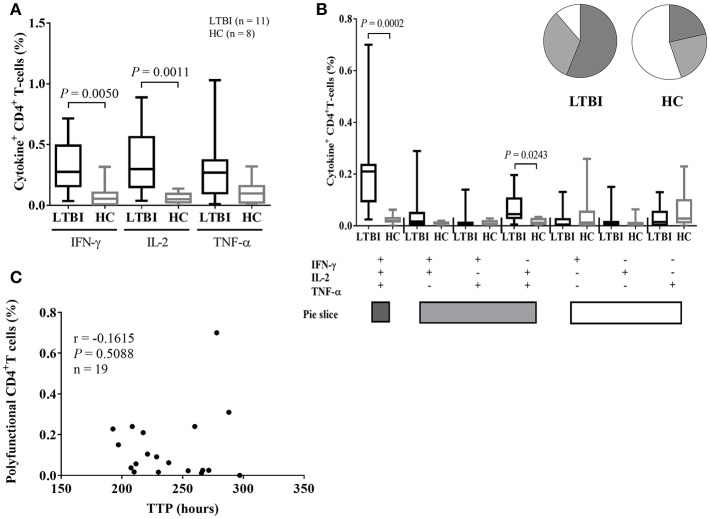
ICS data in LTBI and healthy control groups and correlation between mycobacterial growth inhibition and ICS responses. (A) Single cytokine expression data including IFN-γ, IL-2, and/ or TNF-α for individuals with LTBI (black bars, n = 11) and healthy controls (gray bars, n = 8). The PPD-specific CD4+ T-cell populations making IFN-γ and IL-2 are dominant in the LTBI group. (B) The polyfunctionality of CD4+ T-cell populations in individuals with LTBI (black bars) and HCs (gray bars). The PPD-specific polyfunctional T helper-1 cells are the dominant cell type in the LTBI group. Whole blood samples obtained from healthy adults were stimulated with PPD overnight and CD4+ T-cells assessed for cytokine secretion by intracellular staining. All ICS data is plotted as bars showing medians and interquartile ranges. Whiskers show the range of the data. The Mann-Whitney U-test was used to determine significance. (C) Scatter plots of TTP in hours vs. the percentage of polyfunctional CD4+ T-cells were drawn for all samples where both the mycobacterial growth inhibition assay (MGIA) and the ICS assay were performed (n = 19). Inhibition of mycobacterial growth (of BCG Pasteur) is indicated by TTP in hours for the remaining mycobacteria after incubation with PBMC obtained from study participants. The Mann-Whitney U-test was used to compare growth inhibition ability between the LTBI and HC groups. Spearman's rank correlation coefficient was calculated between growth inhibition and ICS data, indicated as r.